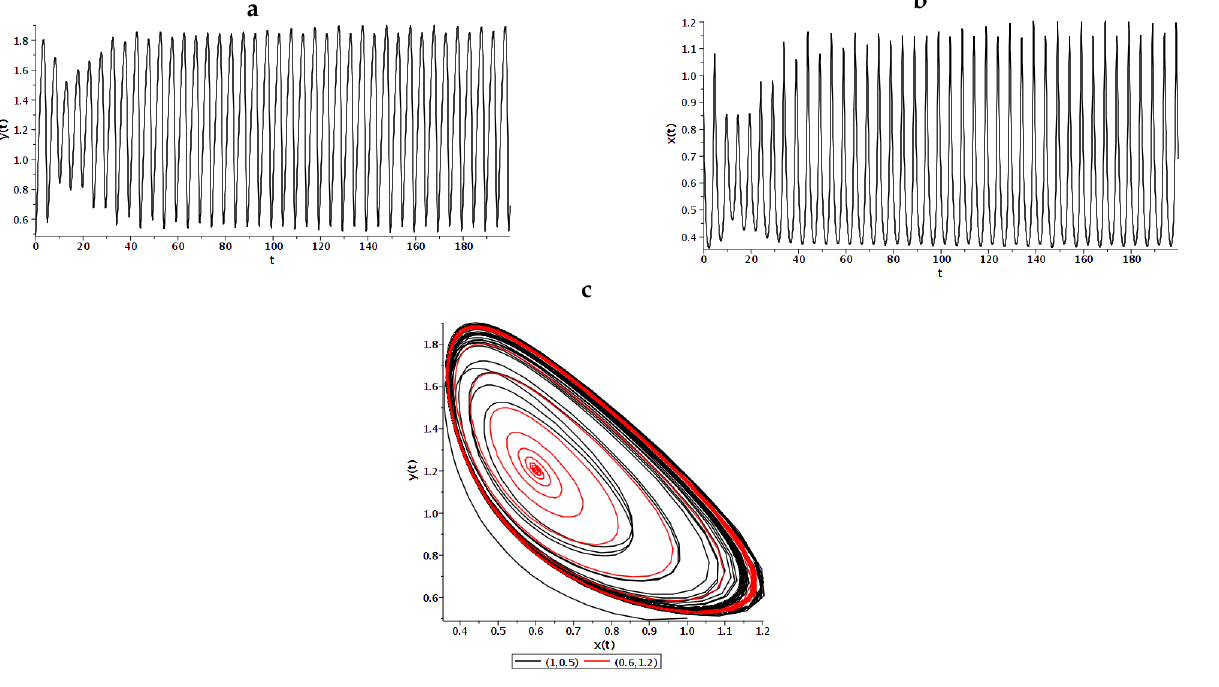
Figure 3. Oscillograms for the concentrations of gs-cracks ( a ) and tr-cracks ( b ); ( c ) phase trajectories constructed under different initial conditions for Example